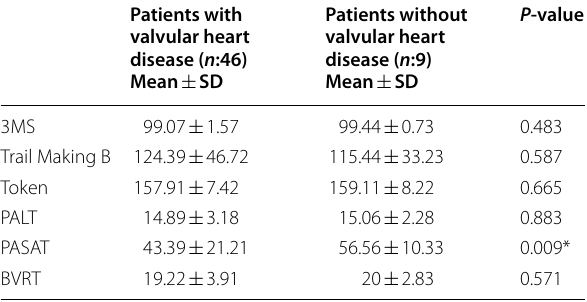
Table 4 Comparison between patients with and without valvular heart disease regarding cognitive function assessment